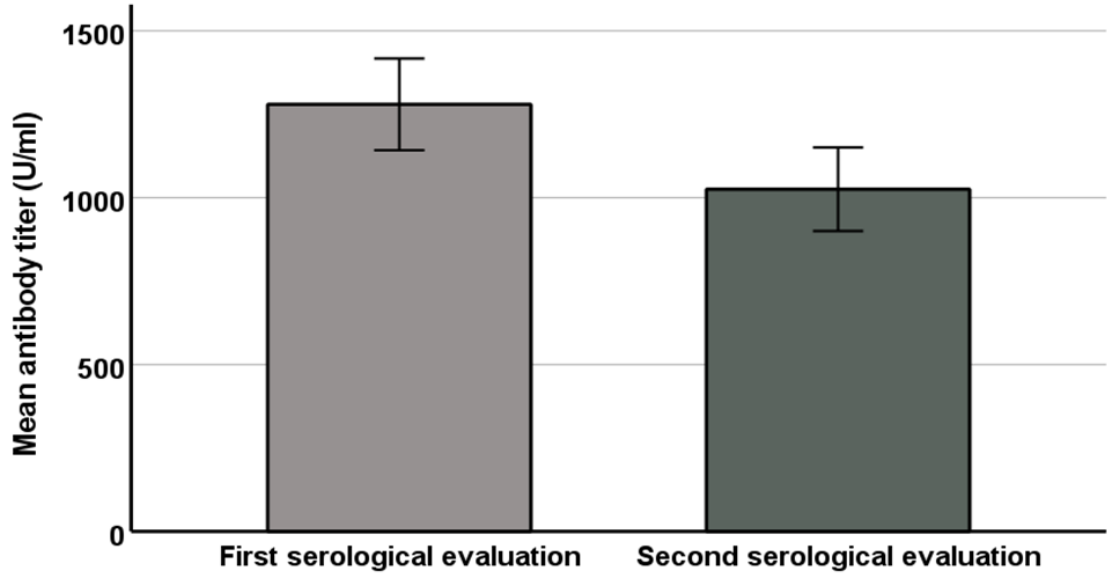
Figure 3. Mean antibody titer levels in first and second serological evaluation.